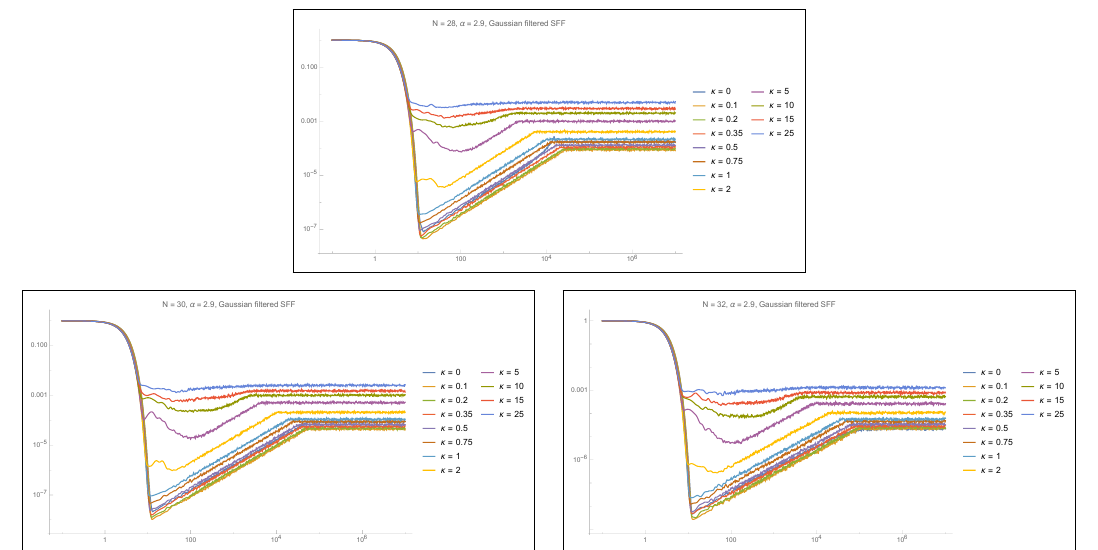
Figure 17 . The Gaussian (cid:12)ltered SFF, for N = 28 ; 30 ; 32, at di(cid:11)erent values of (cid:20) and with (cid:11) = 2 : 9. The ensemble average is done over M = 603 ensemble realizations for N = 28, M = 312 ensemble realizations for N = 30 and M = 150 ensemble realizations for N =